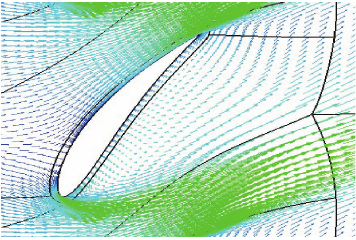
Figure 17: Velocity vector distribution of 6512 at 60 ∘ setting